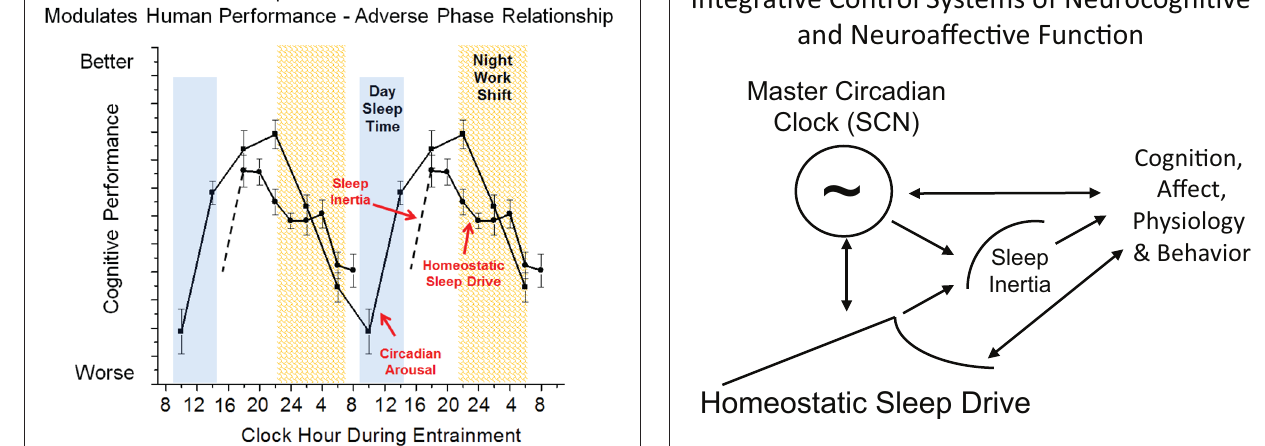
FIGURE 5 | Simplified model of wakefulness-sleep and circadian modulation of cognition during circadian misalignment associated with night work. Data are double plotted and show individual contributions of sleep inertia (grogginess upon awakening from sleep), homeostatic sleep drive (time awake and prior sleep history) and circadian phase (internal biological time) modulation of cognitive function. The interaction between sleep inertia, homeostatic sleep drive and circadian phase are altered during night shift work as compared to day work shown in Figure 3 such that sleepiness is promoted during the work shift.